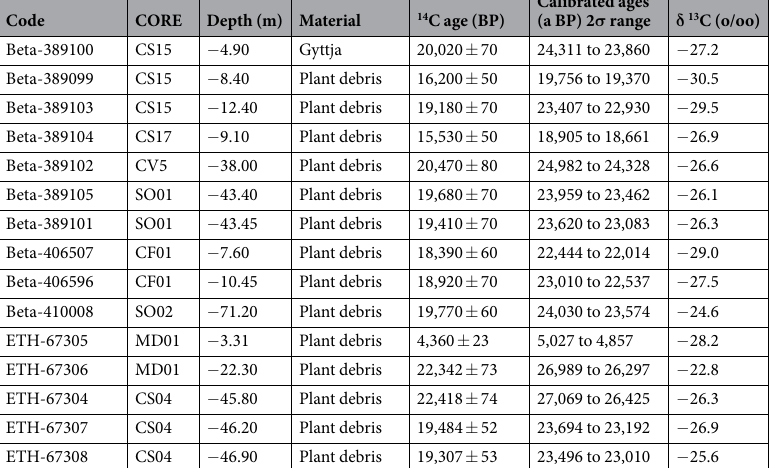
Table 1. Results of AMS radiocarbon analysis.